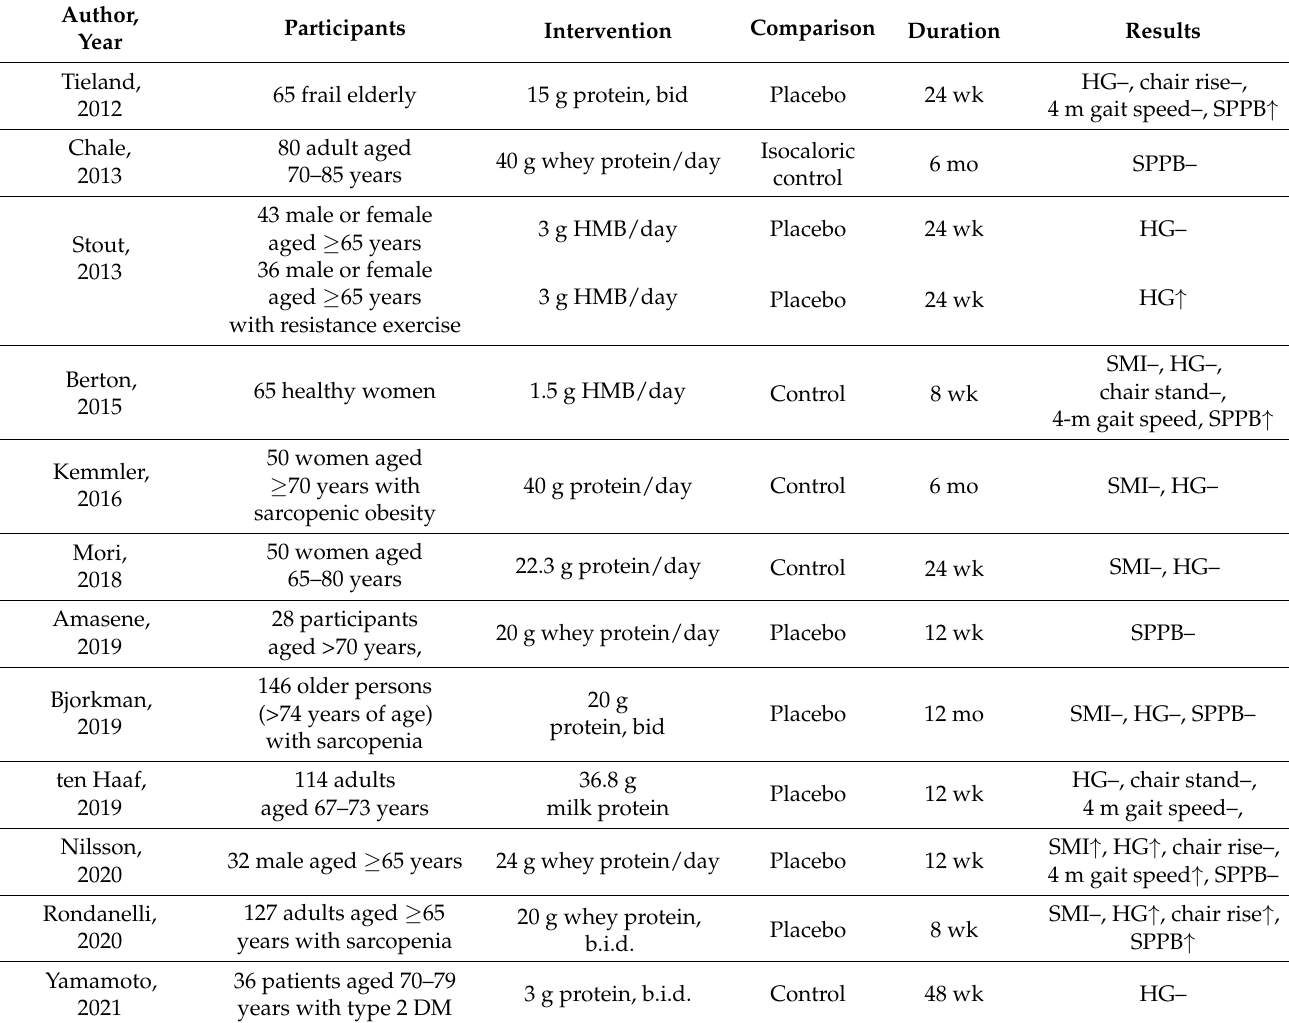
Table 2. Characteristics of the randomized controlled trials included in this systematic review and